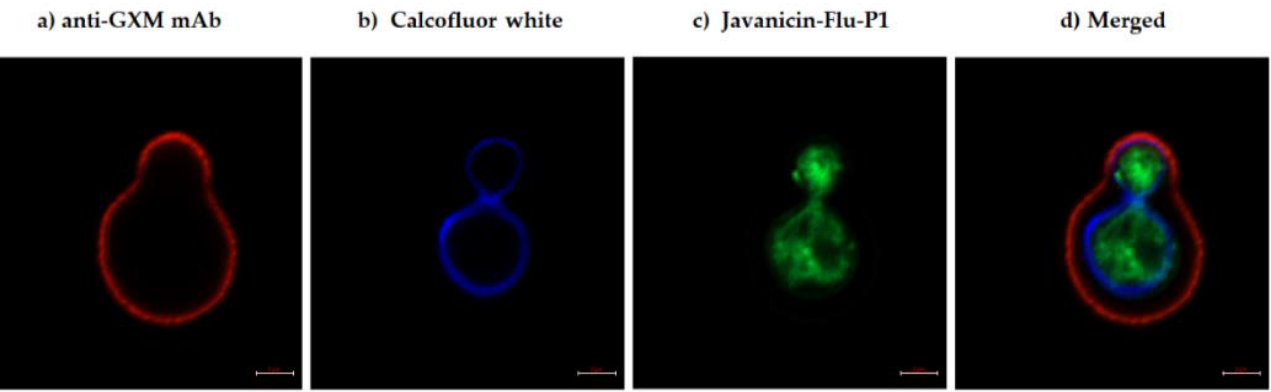
Figure 3. Fluorescence microscopic analysis of r-javanicin-Flu-P1 treated C. neoformans . Cryptococcal cells were incubated with peptide suspension buffer (untreated control) ( a ). C. neoformans was incubated with r-javanicin-Flu-P1 peptide at 2 ( b ) and 8 h ( c ), respectively. Photographs were taken at the same parameter settings. Red fluorescence represented the polysaccharide capsule staining with anti-GXM mAb followed by Alexa 568-conjugated goat anti-mouse IgG. Blue color showed the boundary of fungal cell wall stained by specific cellulose and chitin-binding dye, calcofluor white (CFW). Green fluorescence indicated the localization of antimicrobial peptide inside the yeast cells (scale bar = 10 µm).